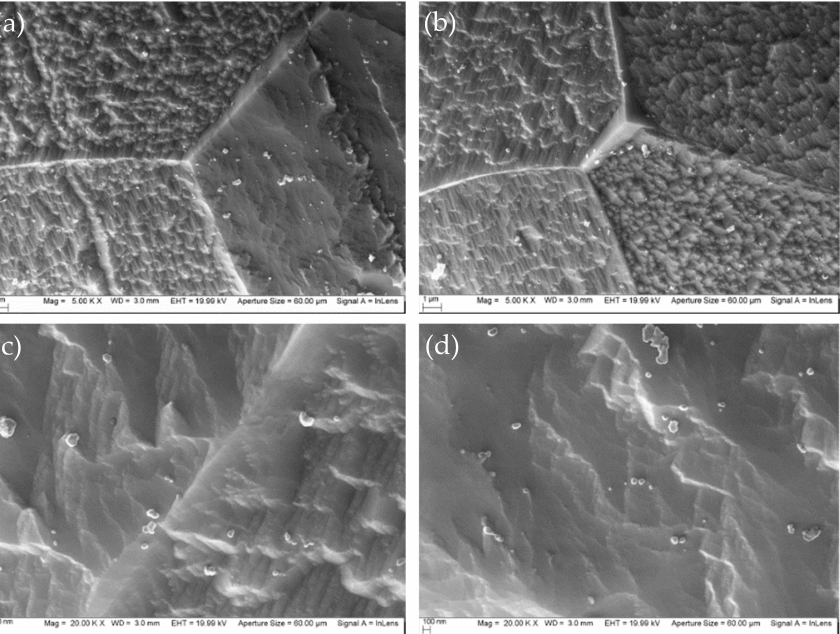
Figure 5. Distribution and morphologies of precipitates in a decarburized sheet observed by FESEM: ( a , b ) grain boundaries and grain interiors at 5000 magnification; ( c ) grain boundaries at 20,000 mag- nification; and ( d ) grain interiors at 20,000